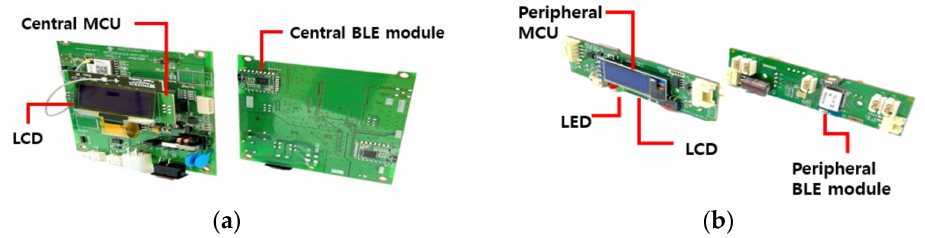
Figure 9. PCBs of central and peripheral processors: ( a ) central processor image; ( b ) peripheral processor image.